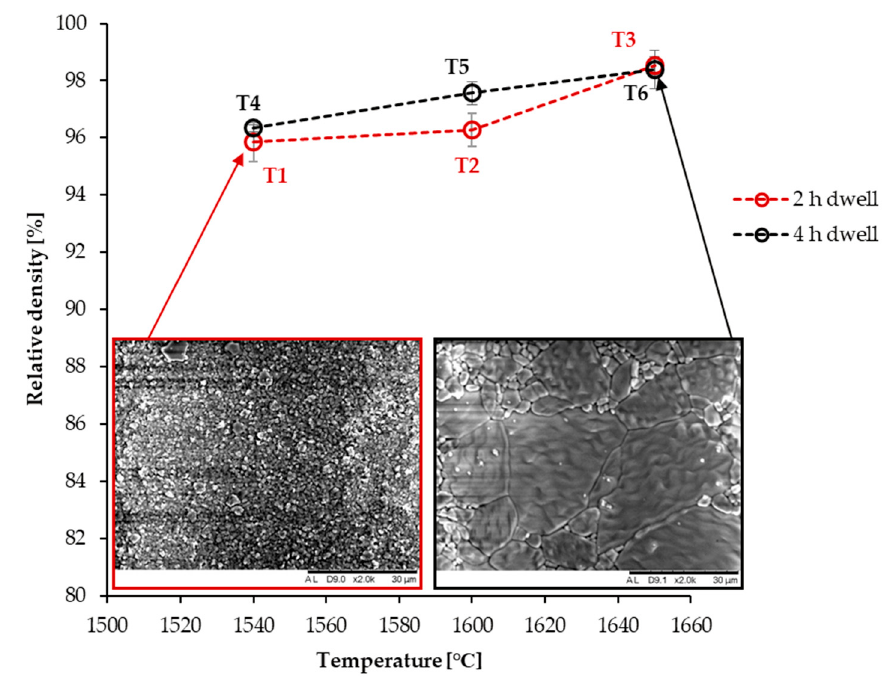
Figure 10. Relative density evolution for 2 h and 4 h dwell at the end of cycles.